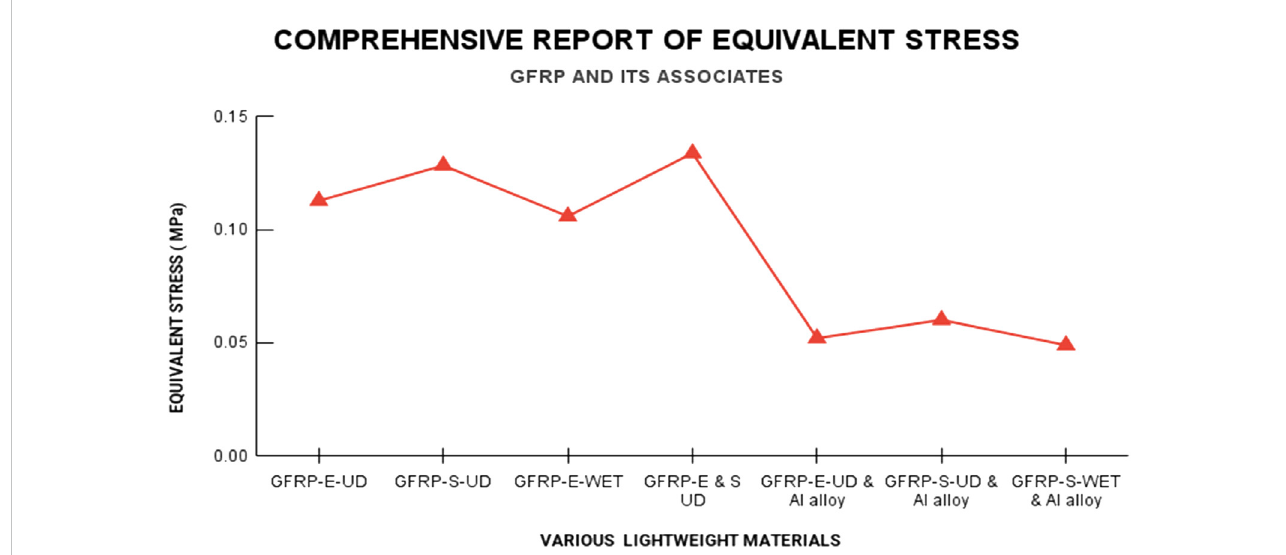
Equivalent stress on half fuselage of RUAV with GFRP and its associate materials.